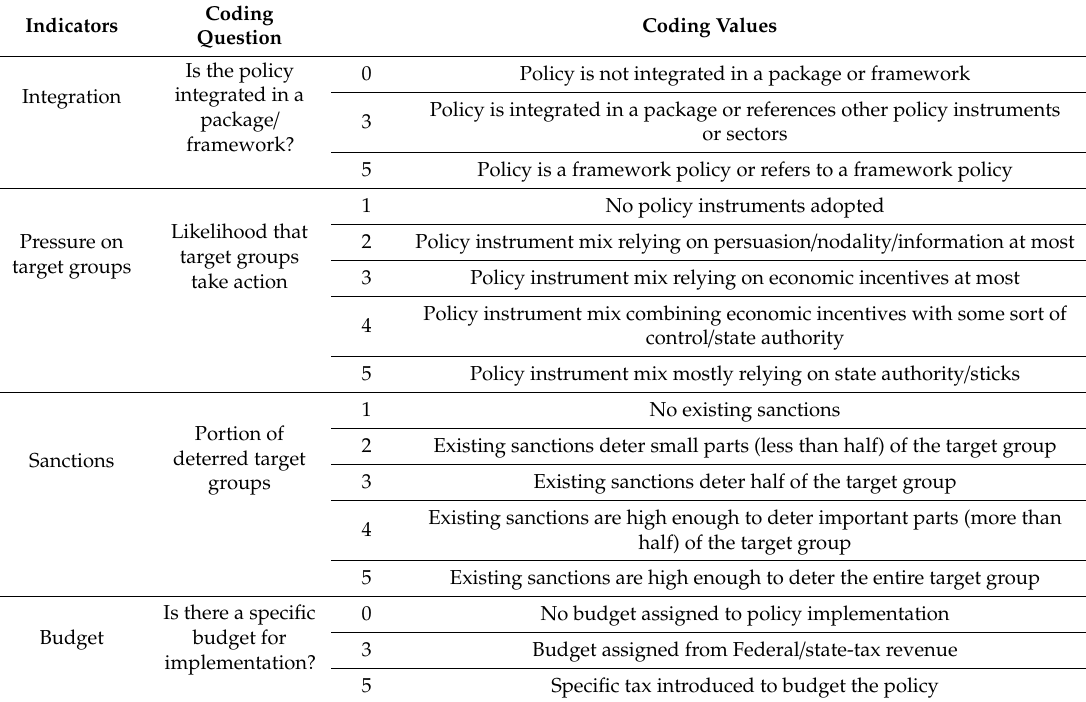
Table 2. Coding scheme for policy design indicators and values; four